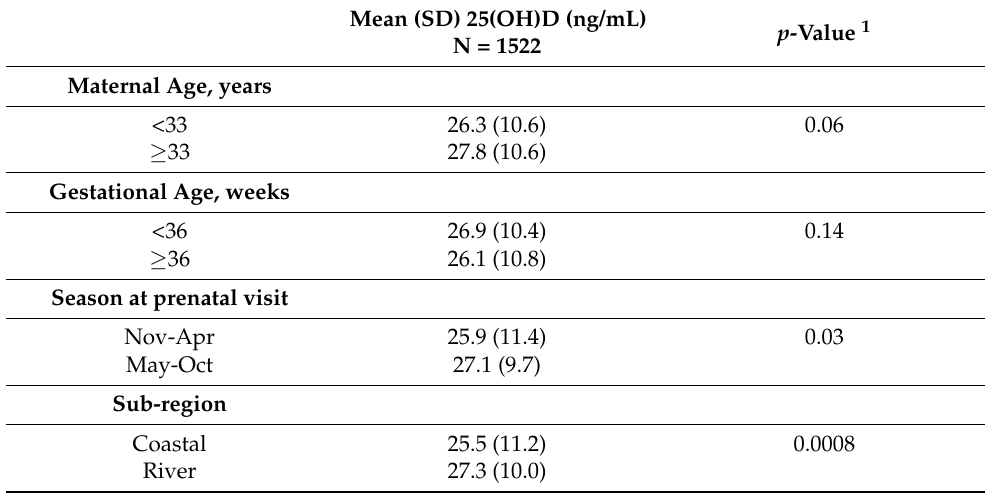
Table 2. Bivariate analysis of late pregnancy (20+ weeks gestation) plasma 25 hydroxyvitamin D concentration in Yukon Kuskokwim Delta prenatal women by maternal characteristics,